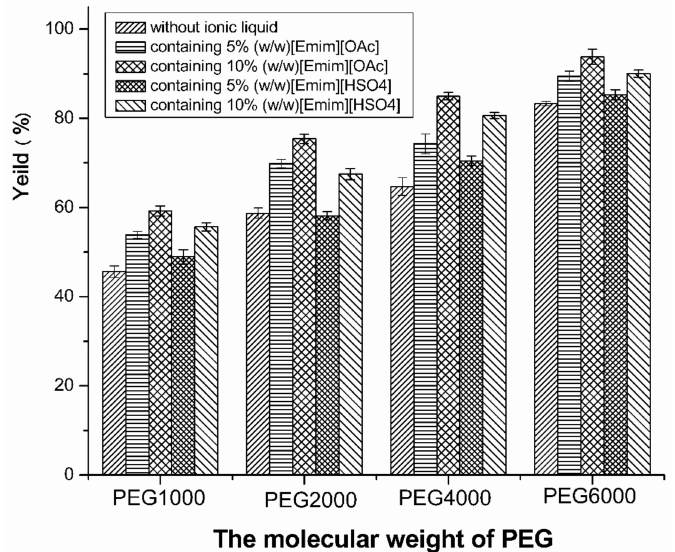
Figure 1. Ionic liquid and PEG molecular weight (MW) on extraction of capsaicin in TAPPIR technology. The HZ816 impregnated resin were prepared in 18% ( w / w ) PEG (1000, 2000, 4000 and 6000) / 15% ( w / w ) sodium citrate top phase. The ionic liquid (10%, w / w ) was added into the ATPSs when needed. The preliminary TAPPIR experiment was implemented at pH 7.0 and 25 ◦ C. For each TAPPIR extraction system, 3 g impregnated resins were dispersed in 10 mL bottom phase of the ATPS with 0.2 g capsicum oleoresin.